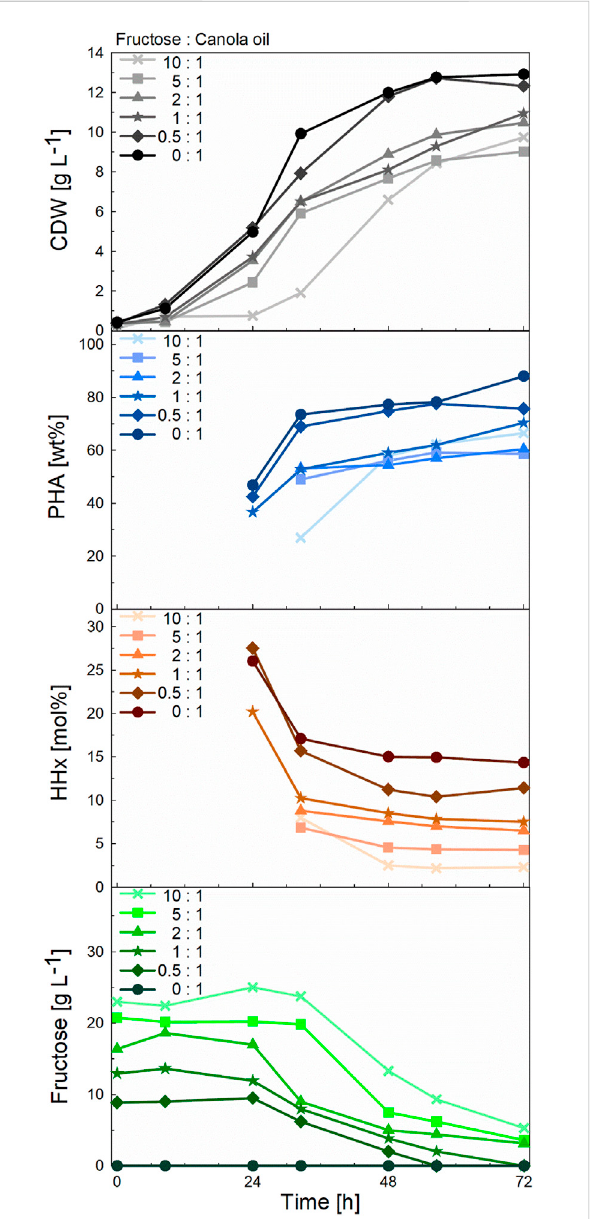
FIGURE 5 Comparison of CDW, PHA, and HHx accumulation- and fructose consumption curves during 1-L bioreactor cultivations of R. eutropha Re2058/pCB113 for tailor-made P(HB- co -HHx) production using mixtures with decreasing fructose to canola oil ratios as carbon source and urea as nitrogen source. Cell dry weight (CDW; g L − 1 ), PHA content of CDW (PHA; wt%), HHx content of PHA (HHx; mol%) and fructose concentration (Fructose; g L − 1 ) values are shown over the course of the cultivation for each mixture with a fi nal carbon content of 10 g L − 1 and a C/N ratio of 22 g g − 1 . The carbon ratio of fructose to canola oil (g g − 1 ) is indicated for each mixture.